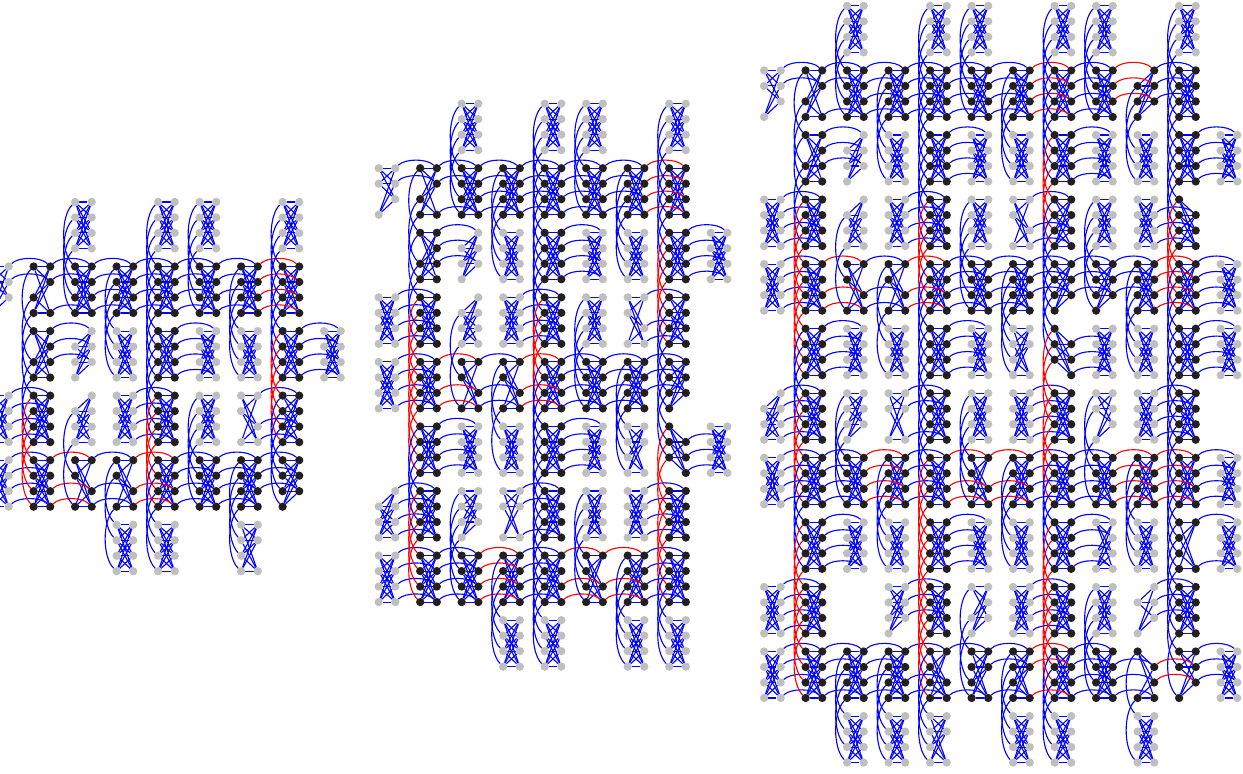
FIG. 3. Layout of several instances of the weak-strong cluster network problem on the D-Wave 2X processor. Shown are three different sizes with 296, 489, and 945 qubits. Each cluster consists of an eight-qubit unit cell of the Chimera graph. Black dots depict − 1 while the gray dots represent qubits with the weak field h 0 . 44 . Blue lines correspond qubits subject to a strong local field h R ¼ L ¼ to strong ferromagnetic couplings ( J ¼ 1 ) and red lines to strong antiferromagnetic couplings ( J ¼ − 1 ). Note that the graphs are somewhat irregular due to the fact that not all 1152 qubits are